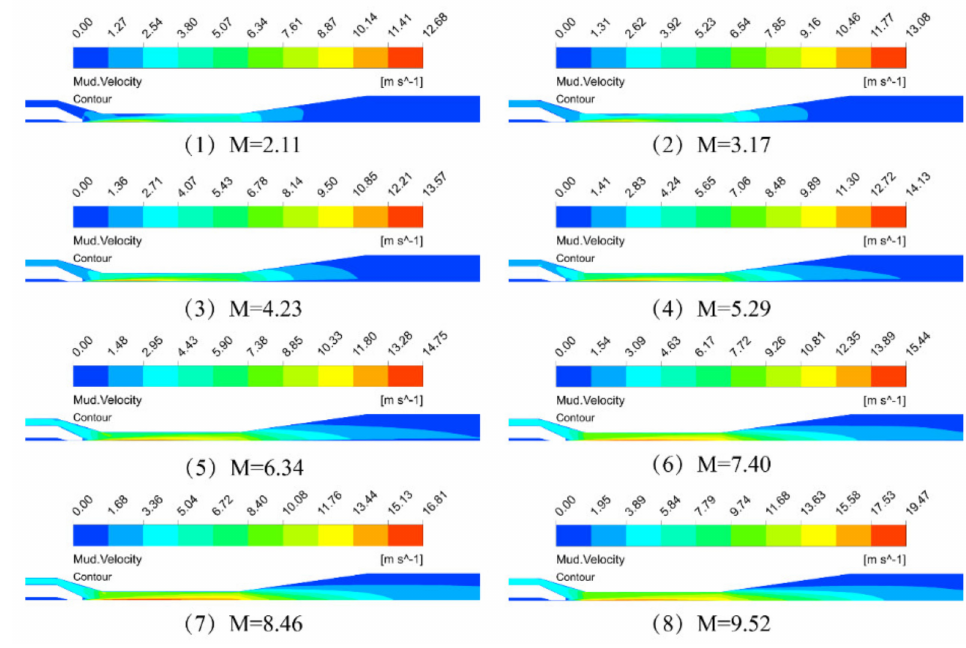
Figure 10. Slurry velocity contours of lengthwise section ( M = 2.11, 3.17, 4.23, 5.29, 6.34, 7.40, 8.46, 9.52).